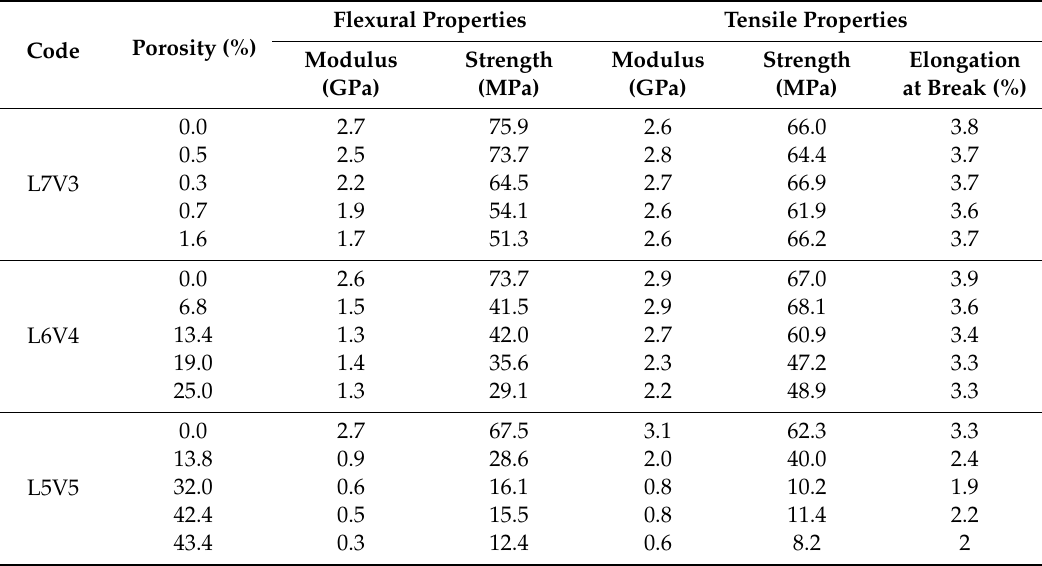
Table 4. The relationship between the mechanical properties and the porosity.